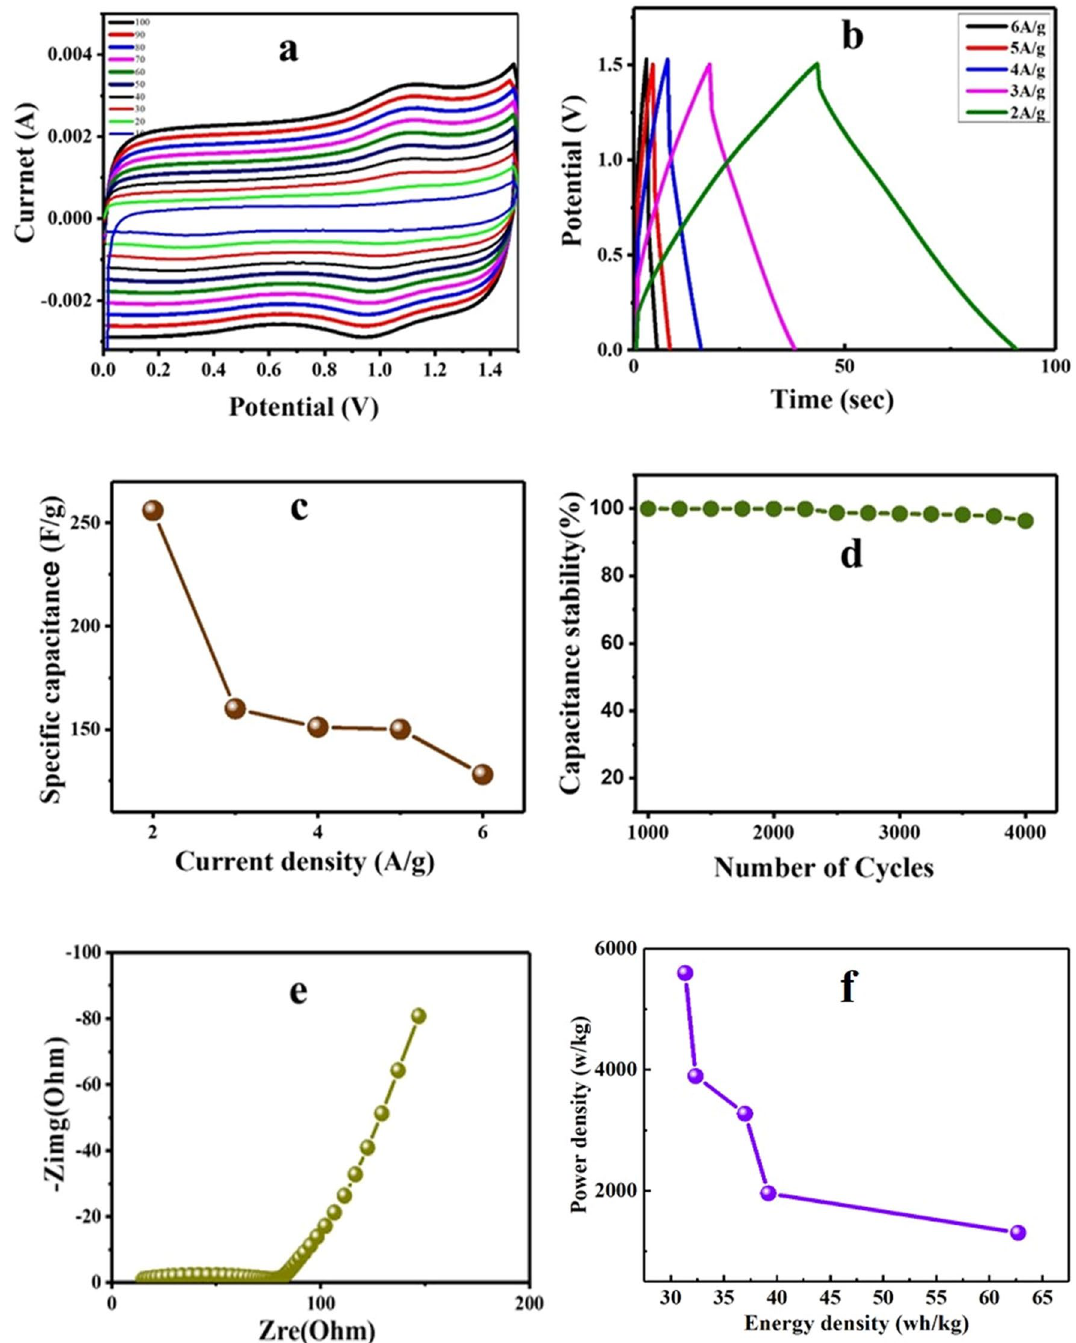
Figure 9. CV analysis of the N-MWCNT/CMC composite for the two electrode configurations via 3 M KOH